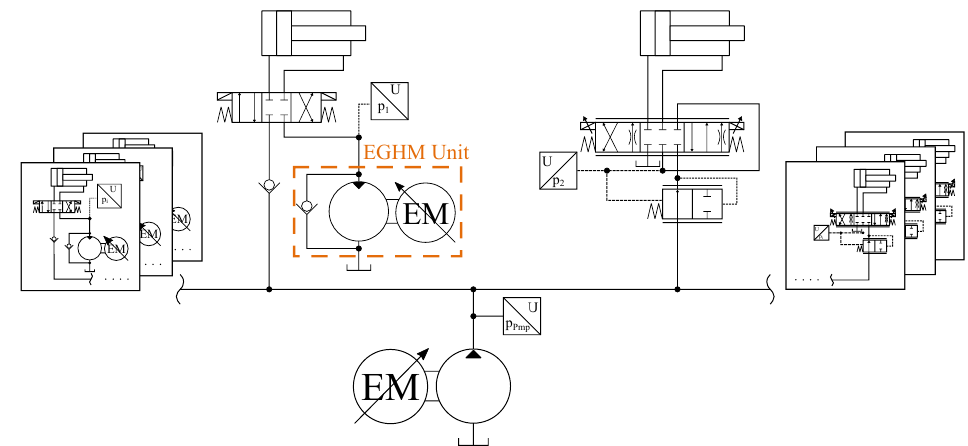
Figure 3. Simplified schematics of the LS system with EGHM units for specific actuators that was presented in